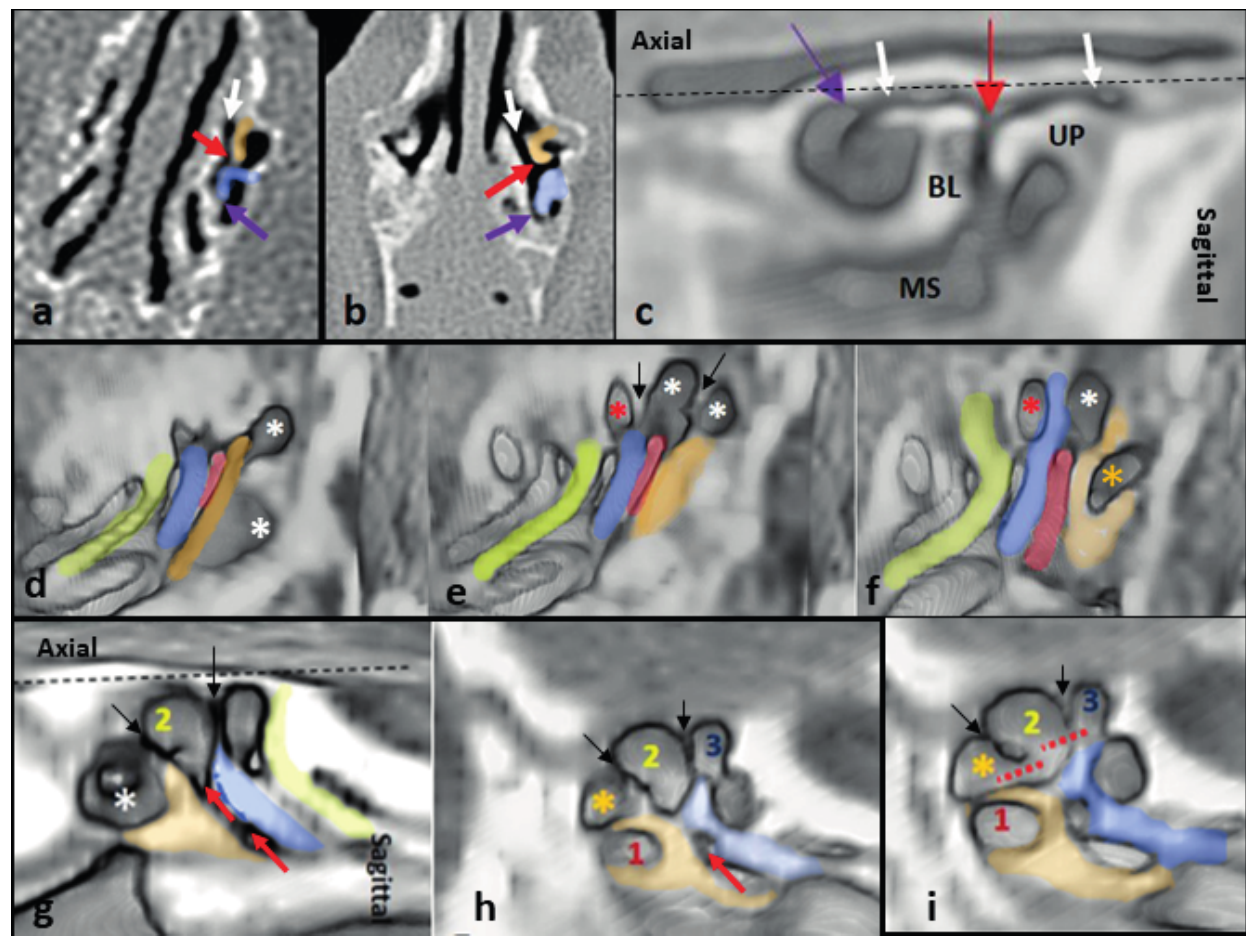
Figure 1. Developmental changes in the lateral nasal wall within the first month of life, as shown in four patients. a.-c. Axial CT images: figs. (a.) at age 3 days, and (b.), at 11 days; with fig. (c.), 3D obliqued sagittal image at 11 days old; viewed from laterally which reveal the MM (white arrows), expanding between the free edge of the Uncinate Lamella (gold outline, UP) and the Bulla Lamella (blue outline, BL) to create the emerging Hiatus Semilunaris and the EI (red arrow). Similarly, the MM expands posteriorly to communicate with the emerging Ethmoid Bulla space (purple arrow). Maxillary Sinus (MS). d.-f. 3D left sided sagittal images of a 7day old patient, viewed progressively from medial to lateral. They reveal the UP (gold) and the EB (blue) “folds”, as well as the anterior rim of the MT Basal Lamella (yellow-green). The Hiatus Semilunaris and EI “groove” in red is between the UP & EB. The RBS is vis- ible between the EB and the MTBL (BaLa). The lateral extension of the MM above the EB and UP creates the respective “pits” (white asterisks) and also the “pit” above the RBS (red asterisk). The space within the outline of the UP is the emerging Infundibular Space, which will become enclosed by the Ethmoid Uncinate Process (IS-EUP) (gold asterisk). g.-i. 34 d old Infant. Sequential 3D obliqued, right sided sagittal images from medial to lateral reveal the UP (gold) and EB (blue) folds, as well as the anterior ridge of the BaLa (yellow-green). The ridges (black arrows) separate the MM evaginations into the LNW, which create the “pits” or “furrows”, that become apparent with progressive medial scrolling into the AES (white asterisks). Note the gradual balloon like expansion of the superior EI (red arrows, yellow 2), as well as the appearance of the IS-EUP (red 1), the space above the EUP (gold asterisk) and the space above the EB (3). Note also, the remodeling dissolution of the “dark” cartilaginous ridges, most pronounced in fig. (i.), between the spaces above EUP (gold asterisk), the superior EI (yellow 2) and above EB (3), which is highlighted by the red doted lines. This reveals the early phase in the creation of a single superior antero-later- al space within the AES, above both IS-EUP and Ethmoid